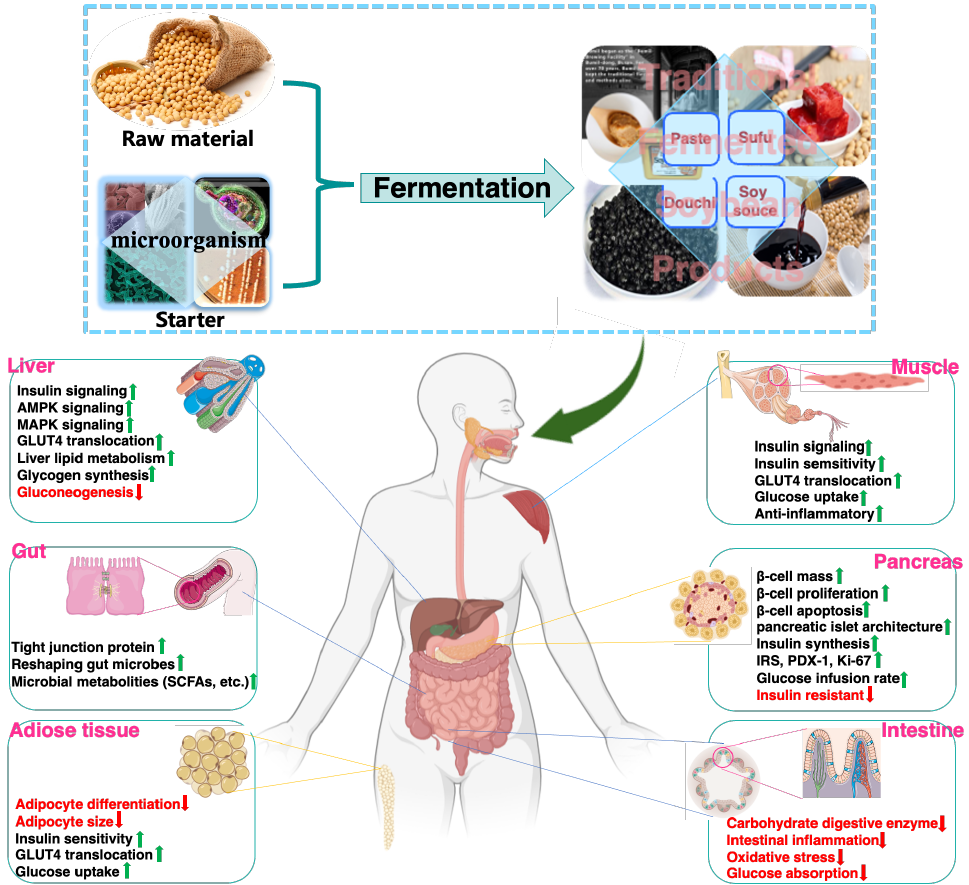
Figure 3. Glucoregulatory mechanisms of FSP on major Figure 3. This is a figure. Schemes follow the same formatting. If there are multiple panels, they should be listed as: ( a ) Description of what is contained in the first panel. ( b ) Description of what is contained in the second panel. Figures should be placed in the main text near to the first time they are cited. A caption on a single line should be centered. Table 1. This is a table caption. Tables should be placed in the main text near to the first time they are cited.